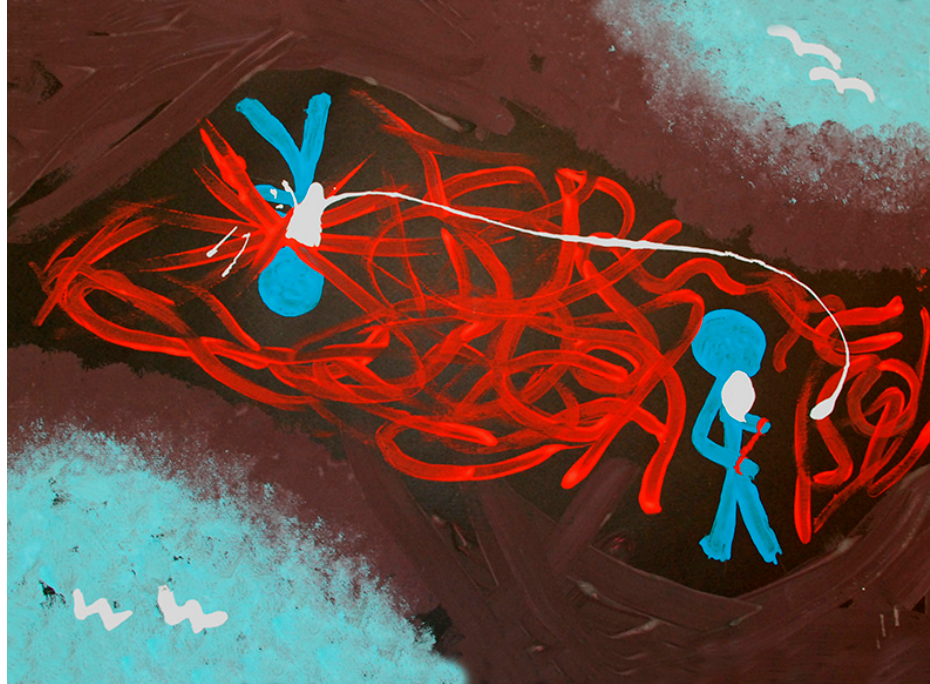
Figure 6. Marta (aged 38, psychotic disorder), The Child Who Did Not Want to Come and the One Who Will Not Come Anymore.